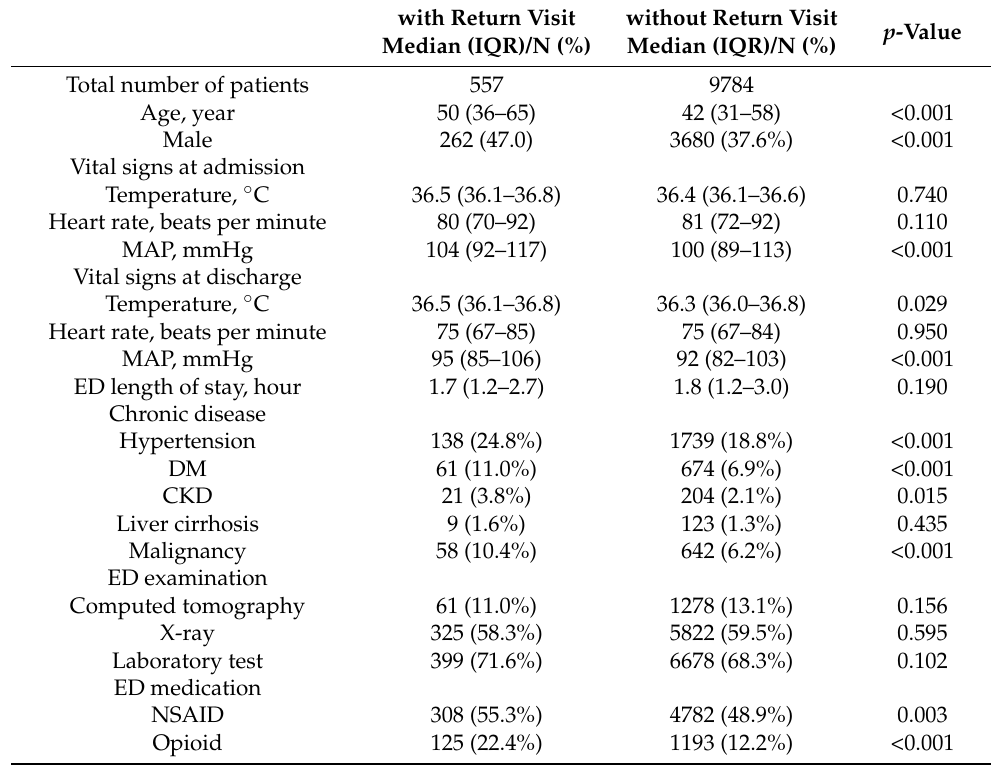
Figure 2. Cumulative proportion of return visit by hours. Table 1. Demographic and clinical characteristics of patient presenting nonspecific abdominal pain with and without return